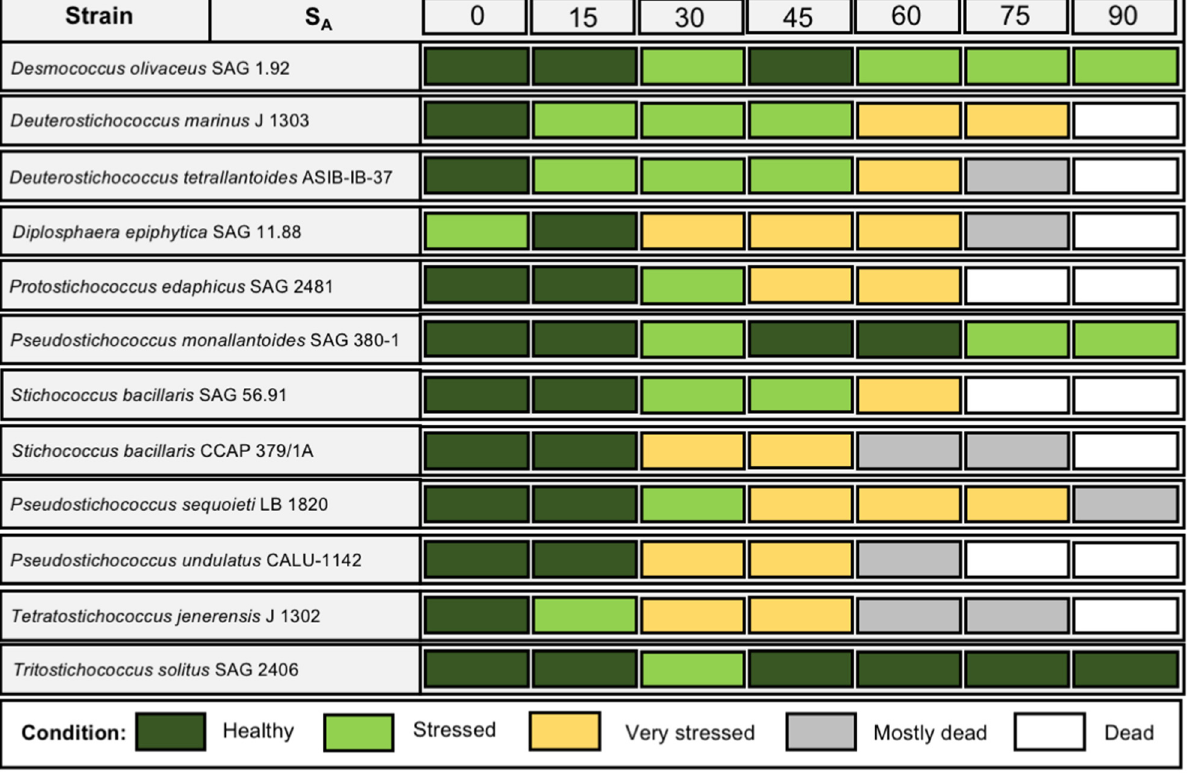
Figure 2. Tabular results of strain survival at 0–90 S A ; individual cultures of strains were evaluated after 8 weeks of growth in the respective media. The condition colors correspond approximately to culture color and health in the test tubes.